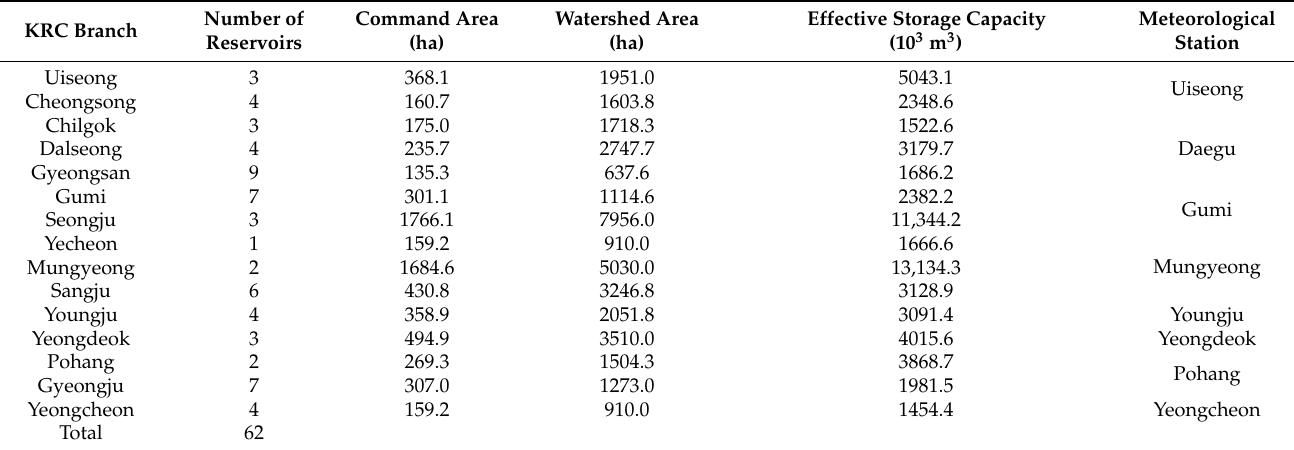
Figure 1. Locations of selected agricultural reservoirs and meteorological stations in the study area. Table 4. Characteristics of the selected agricultural reservoirs in this